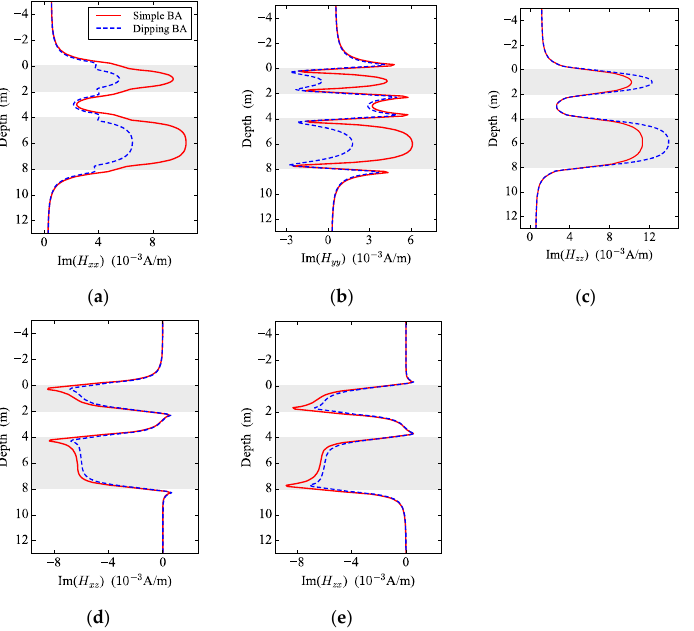
Figure 13. Responses of the tool in the layered simple BA and dipping BA formations. ( a ) Im ( H xx ) . ( b ) Im ( H yy ) . ( c ) Im ( H zz ) . ( d ) Im ( H xz ) . ( e ) Im ( H zx )